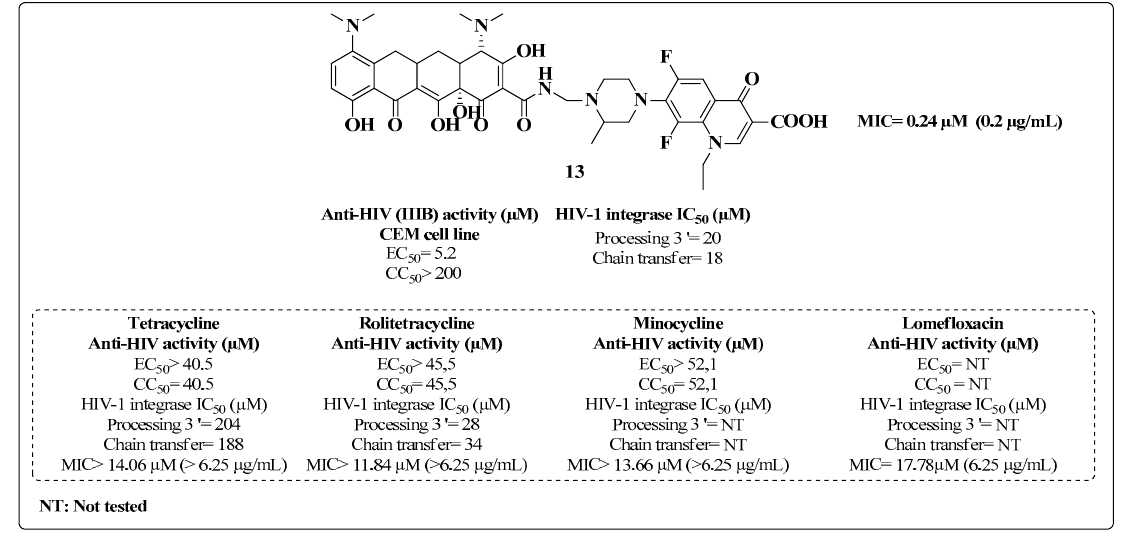
Figure 12. Results of anti-HIV activity (CEM cells), inhibition of the HIV-1 integrase enzyme and anti-MTB activity of Compound 13 , derived from tetracycline and fluoroquinolone [91].